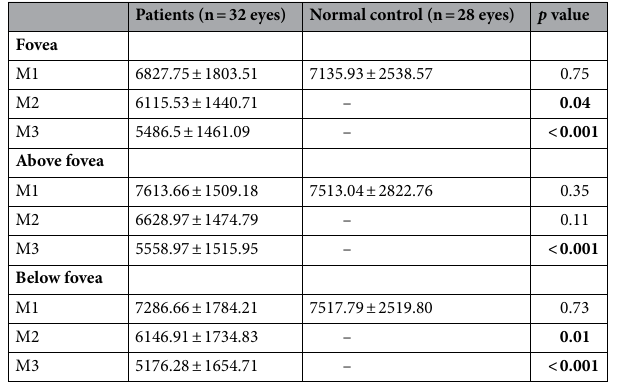
Table 3. Comparison between the area of outer plexiform layer (OPL) (in mean pixel square) between patients with tubercular serpiginous-like choroiditis and normal healthy control subjects. M1: Baseline visit. M2: Intermediate visit at month 3. M3: Final visit at month 6. The p value was calculated by using Mann– Whitney U test. Significant values are in bold.